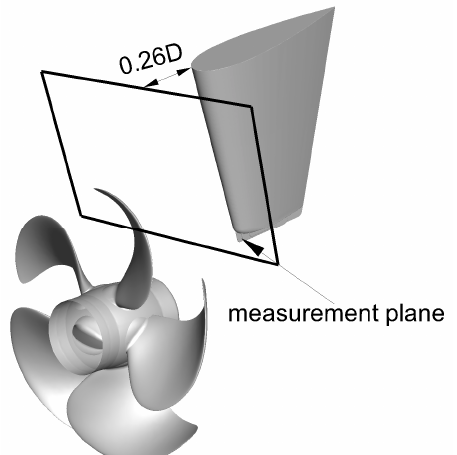
Figure 9. Measurement plane location in which inflow angles were predicted using the axial and